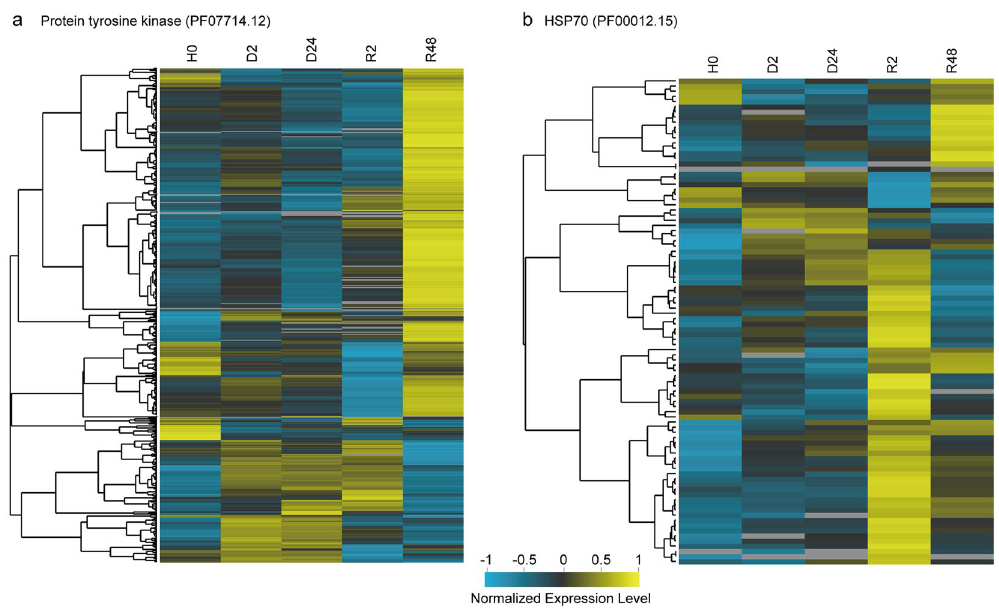
Figure 6. Heatmaps illustrating the expression profiles of the protein tyrosine kinase ( a ) and heat shock protein 70 family ( b ) transcripts upon dehydration and